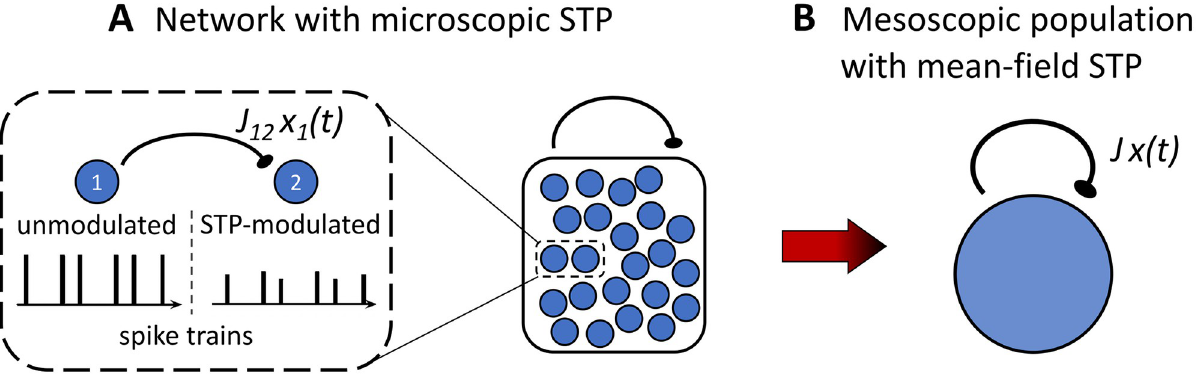
Fig 1. From microscopic to mesoscopic population dynamics. (A) Network with microscopic short-term plasticity. Dashed region shows a zoom into a pair of interconnected neurons: presynaptic neuron 1 sends out an unmodulated spike train to postsynaptic neuron 2 that receives the spike-train modulated by short-term depression. (B) Mesoscopic mean-field model with one effective synapse undergoing short-term